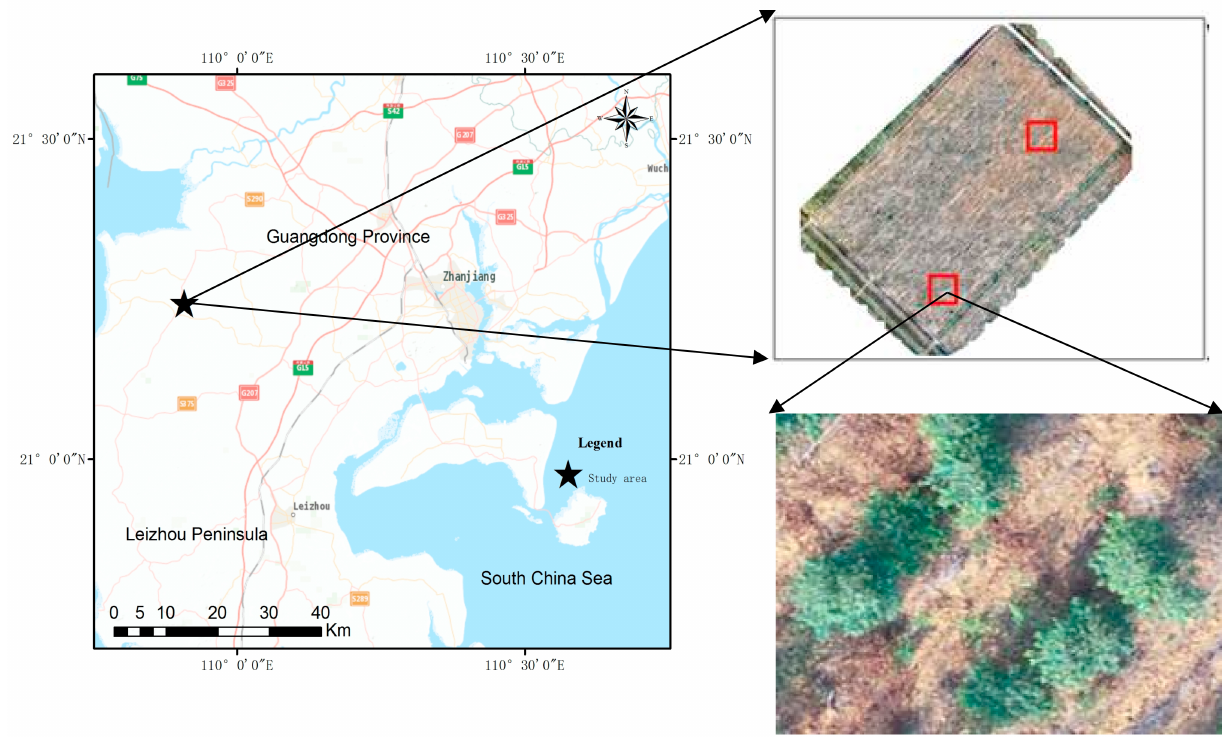
Figure 1. The orthoimages and the locations of two test